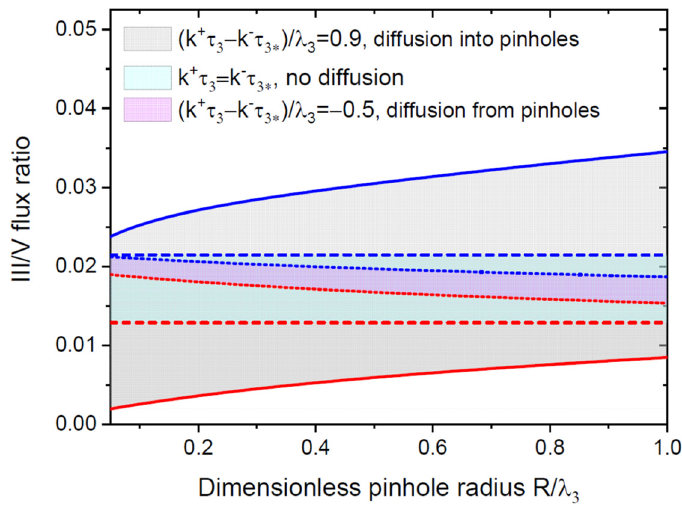
Figure 6. SAG windows for vertical NWs in terms of III/V flux ratio versus dimensionless pinhole radius R / λ 3 in the case of positive (solid lines), zero (dashed lines), and negative (dotted lines) diffusion flux of group III adatoms from the mask surface into the pinholes, corresponding to different values of k + τ 3 − k − τ 3 ∗ shown in the legend. The dimensionless pinhole pitch P / λ 3 is fixed at 4.